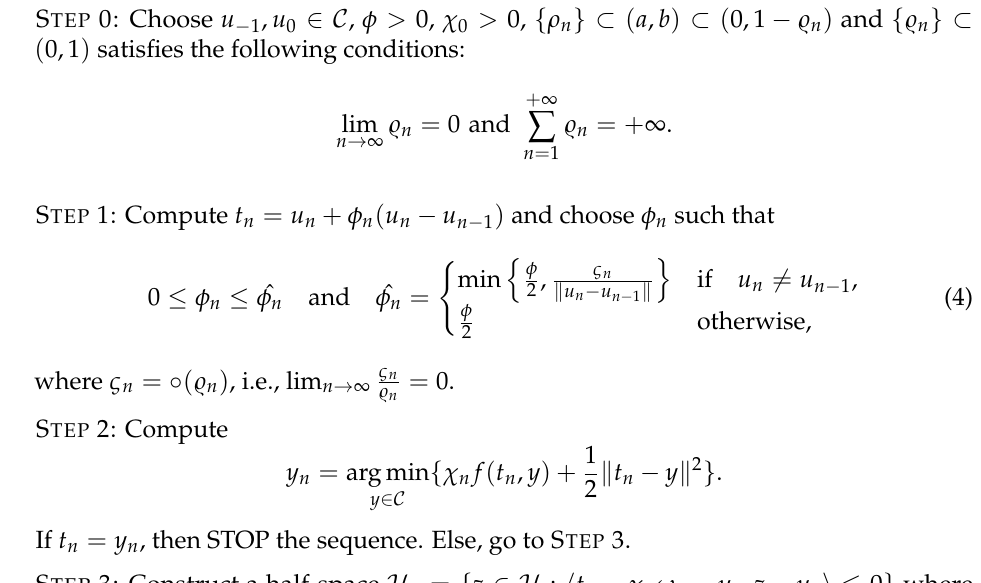
Algorithm 1 (Explicit Accelerated Strong Convergence Iterative